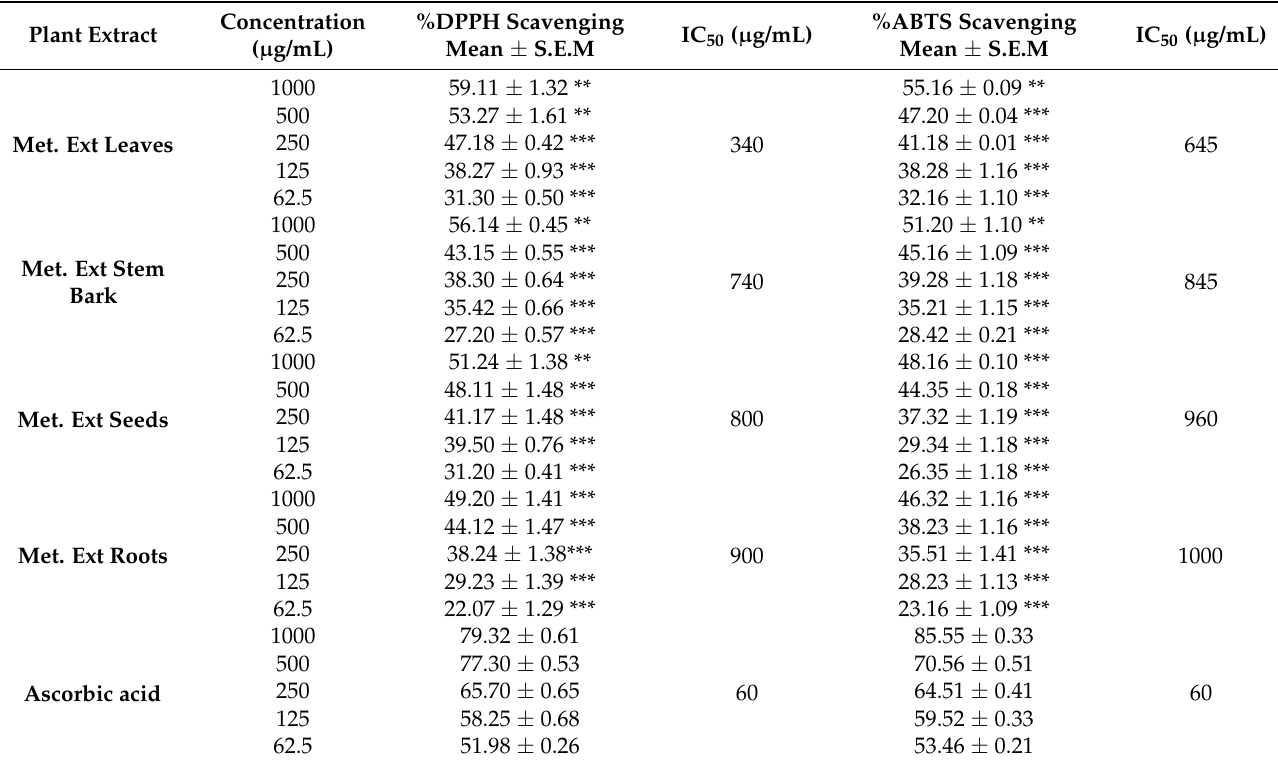
Table 2. Percent DPPH and ABTS free radical screening activity of A. nitida methanolic extracts at various concentrations. Plant